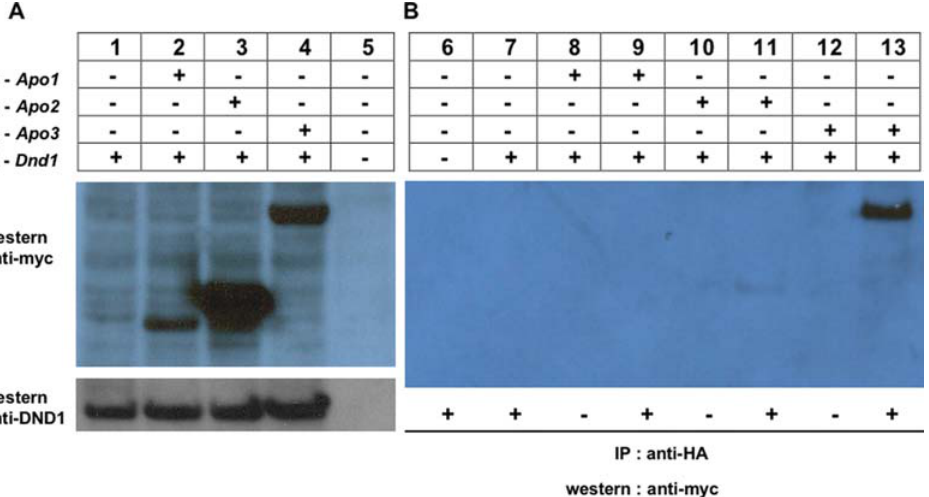
Figure 3. DND1 interacts with APOBEC3 in mammalian cells. (a) Expression of APOBEC proteins and DND1 in 293T transfected cells . Cells were co-transfected with expression vectors encoding HA-tagged Dnd1 (lanes 1, 2, 3 & 4) and myc-tagged Apobec1, Apobec2 and Apobec3 (lanes 2, 3 & 4, respectively). After 48 h, transfected cells were lysed. An aliquot (10 m g) was electrophoresed for western blotting with anti-myc (top panel) and anti-DND1 antibody (bottom panel) to detect expression of proteins. ( b ) HA-DND1 pulls-down APOBEC3 from cells . Lysates from transfected cells in (a) were used. Equal aliquots (50 m g) were used for immunoprecipitation (IP) using anti-HA antibody ( + ) to pull down HA-DND1 (lanes 6, 7, 9, 11 & 13). Control lanes had no antibody ( 2 ). Following IP, electrophoresis and transfer to membranes, western blotting was performed